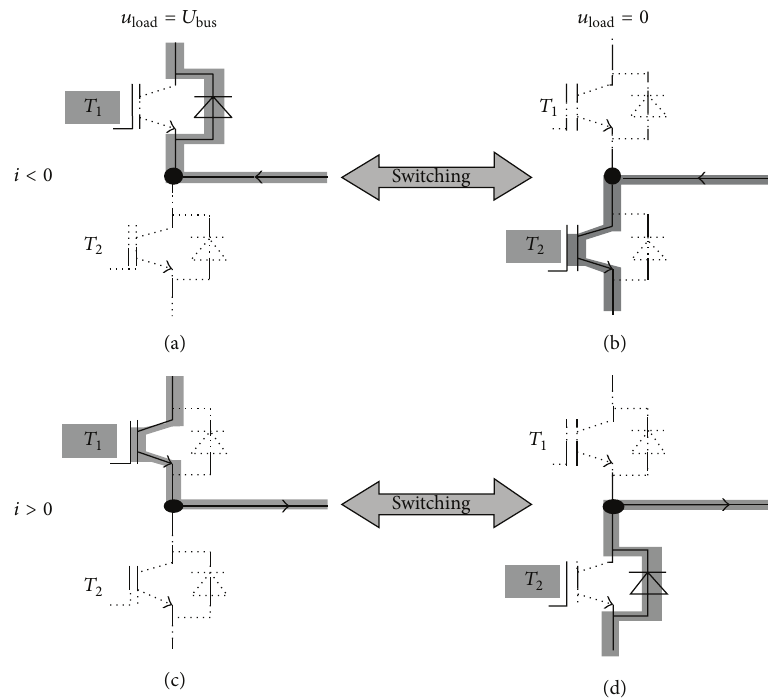
Figure 10: On-state switching and current flow in power stage.